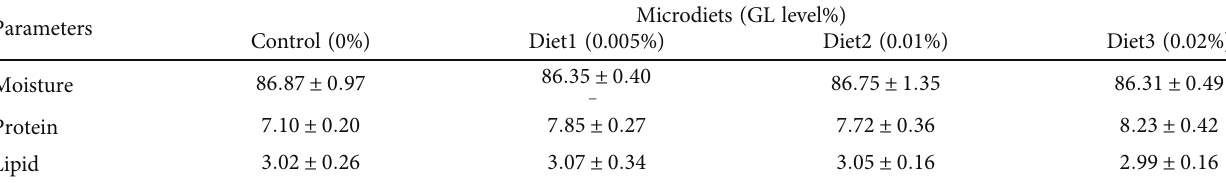
Table 4: E ff ects of GL supplementation on body composition of large yellow croaker larvae. Parameters